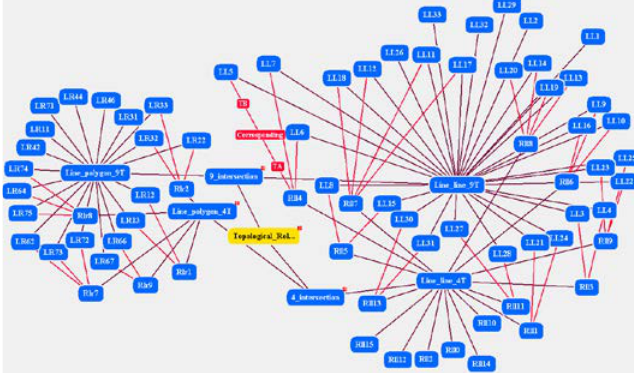
Figure 7. Topic map of 4I model and 9I